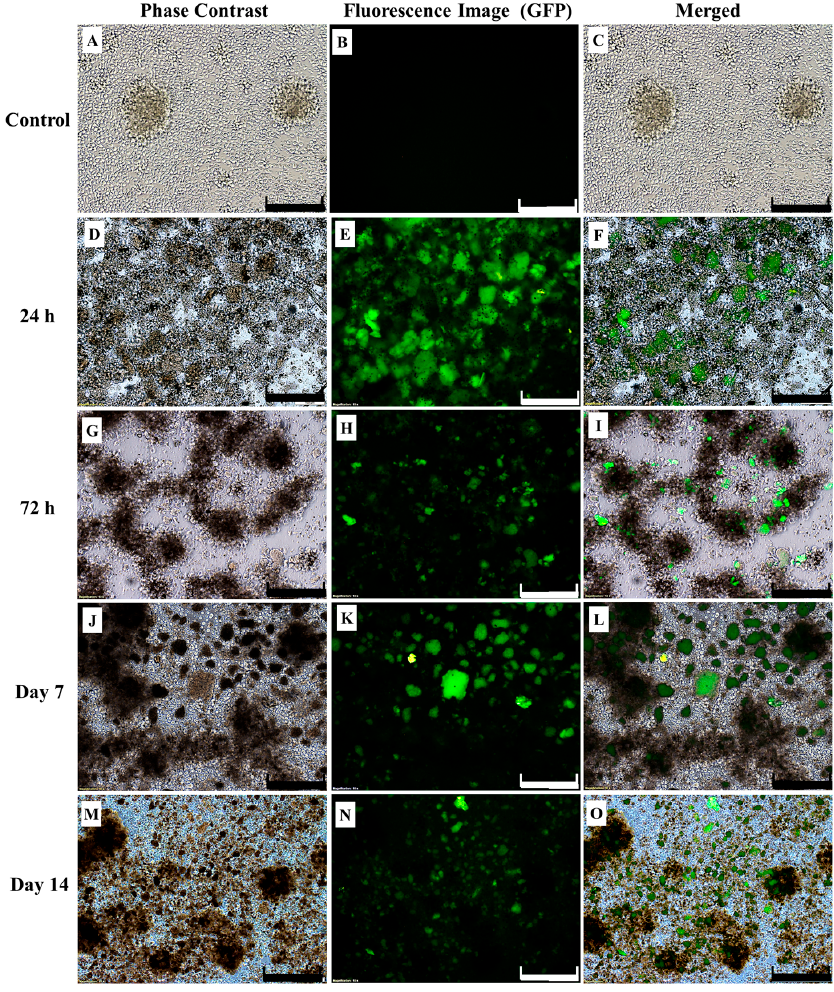
Figure 1. Verification of transduction efficiency of the chimeric antigen receptor (CAR) based on fluorescence microscopy of green fluorescent protein (GFP) expression on human CD3+ T-cells. Phase contrast, GFP fluorescence, and merged images of human T-cells are shown. The images shown are control ( A – C ), 24 h ( D – F ), 72 h ( G – I ), day 7 ( J – L ), and day 14 ( M – O ) post-transduction by spinoculation (day 0). ( A – C ) Clumped T-cells are observed in due to activation by DynaBeads prior to transduction. T-cells that have successfully undergone transduction (CAR-T cells) showed significant amounts of GFP expression at 24 h ( D – F ) and 72 h ( G – I ). These images are compared to the control, non-transduced T-cells ( A – C ). Cells were imaged at 100 × magnification (the scale bar represents 100 µ